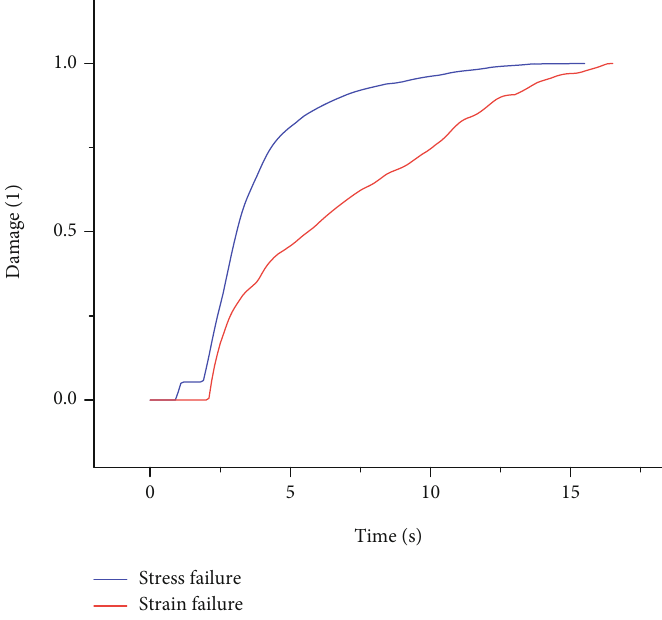
Figure 13: Comparison of damage evolution between the stress failure and strain failure criteria.